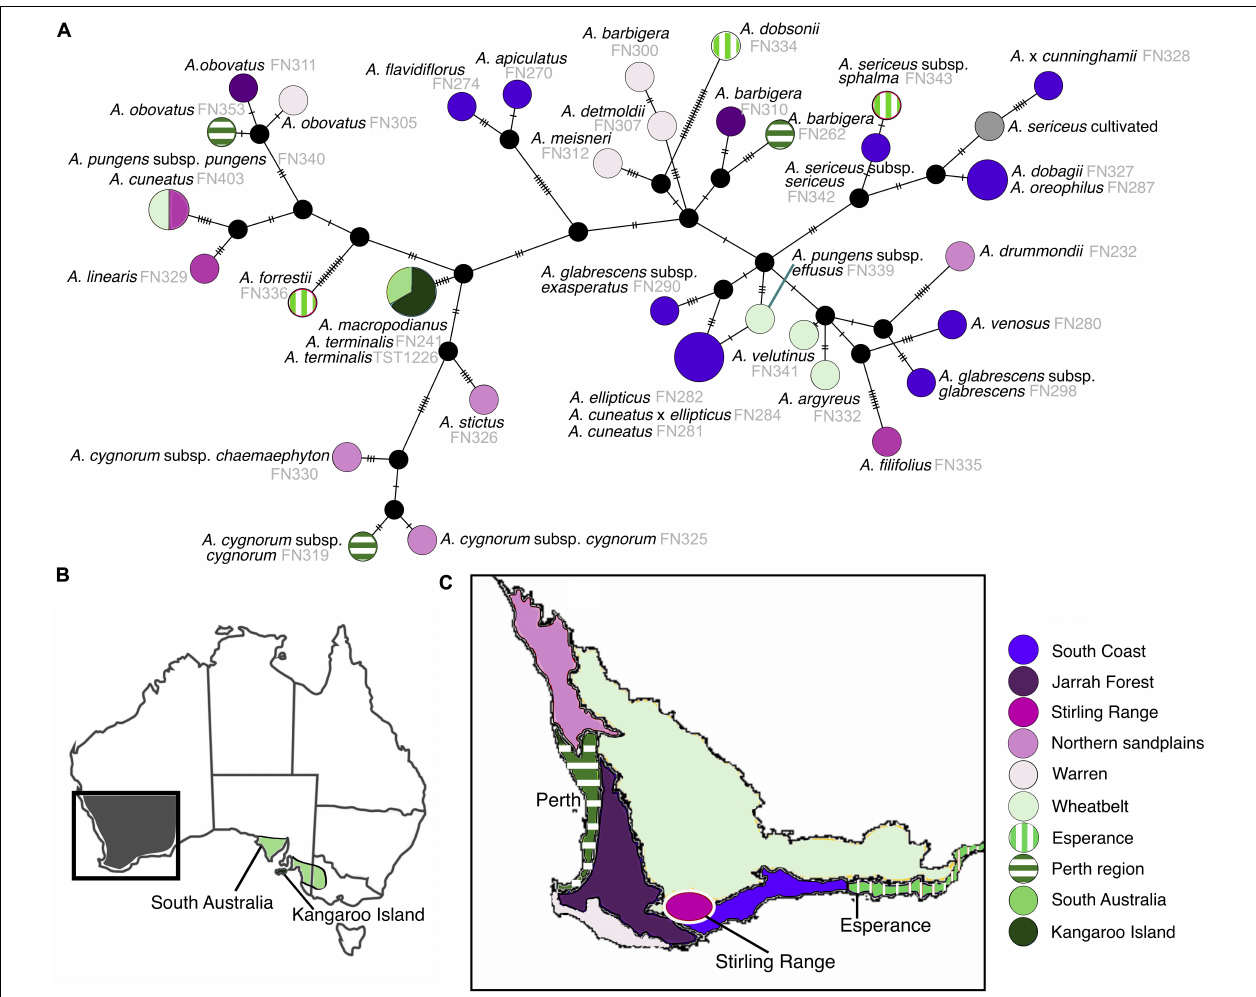
FIGURE 6 | (A) TCS network of Adenanthos chloroplast haplotypes colored according to subregions of southwestern and South Australia. Circle size represents number of taxa (1–3) sharing chloroplast haplotypes. Black dots represent missing, unsampled, or extinct intermediate haplotype lineages. (B) Map of Australia with box highlighting southwestern Australia and colored regions in South Australia indicate distribution of Adenanthos terminalis and macropodianus. (C) Map of southwestern Australia showing each of the subregions.